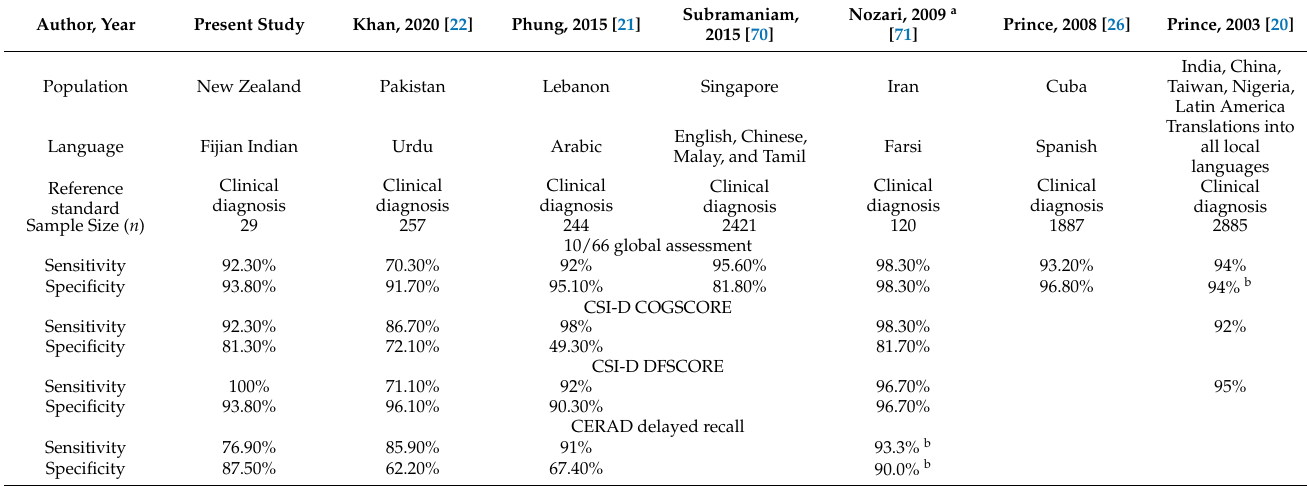
Table 6. Comparison of sensitivity and specificity of the 10/66 dementia protocol and its sub-components in samples from different